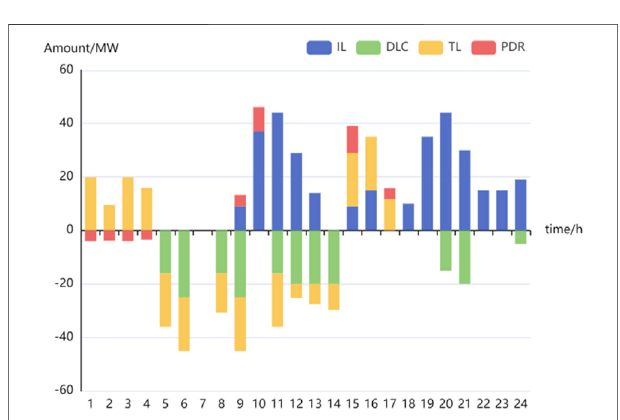
FIGURE 6 | Response values of DRs at each period in Scenario 3